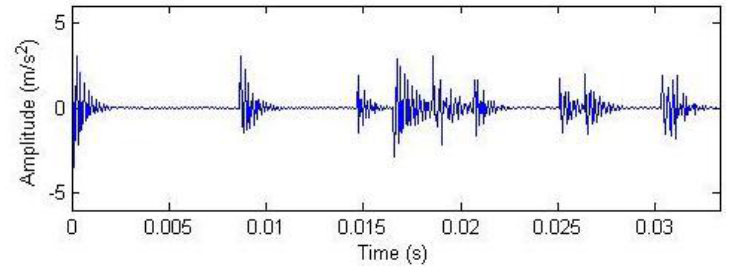
Figure 9. Reconstructed signals with single- matching and hard